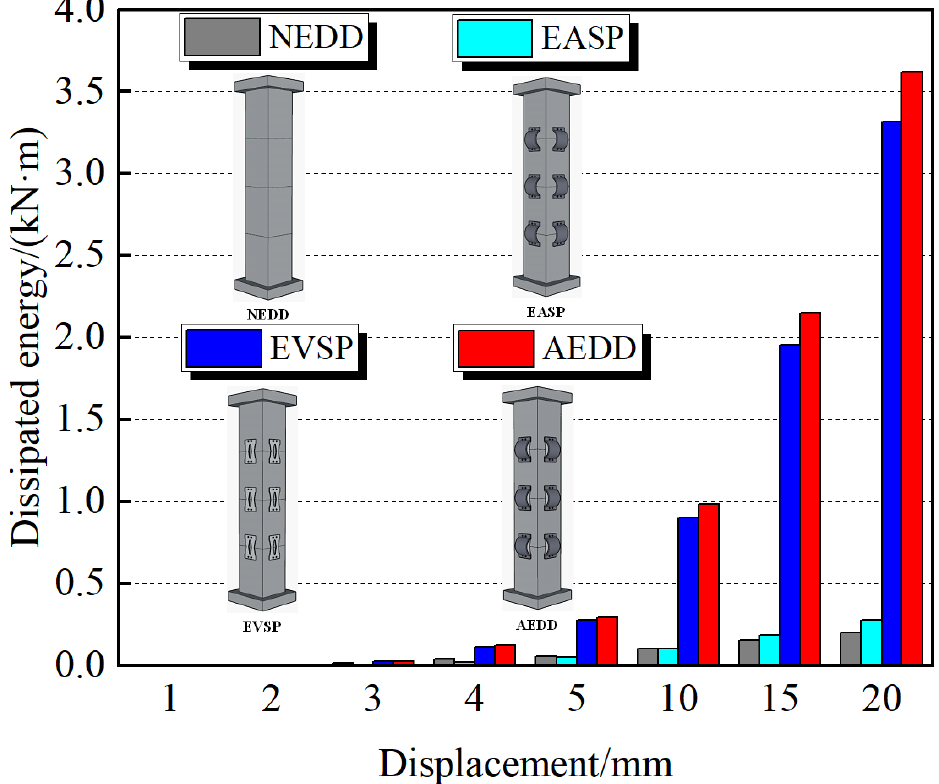
Figure 15. Columnar diagram of the cumulative energy consumption of different forms of piers.